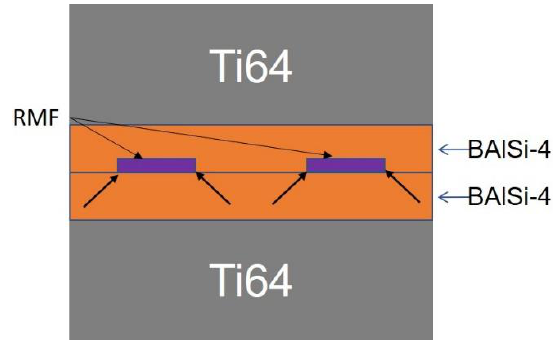
Figure 13. Suggested “embedded RMF joining” schematic; arrows indicate where the adjacent BAlSi- 4 surfaces would fuse together.